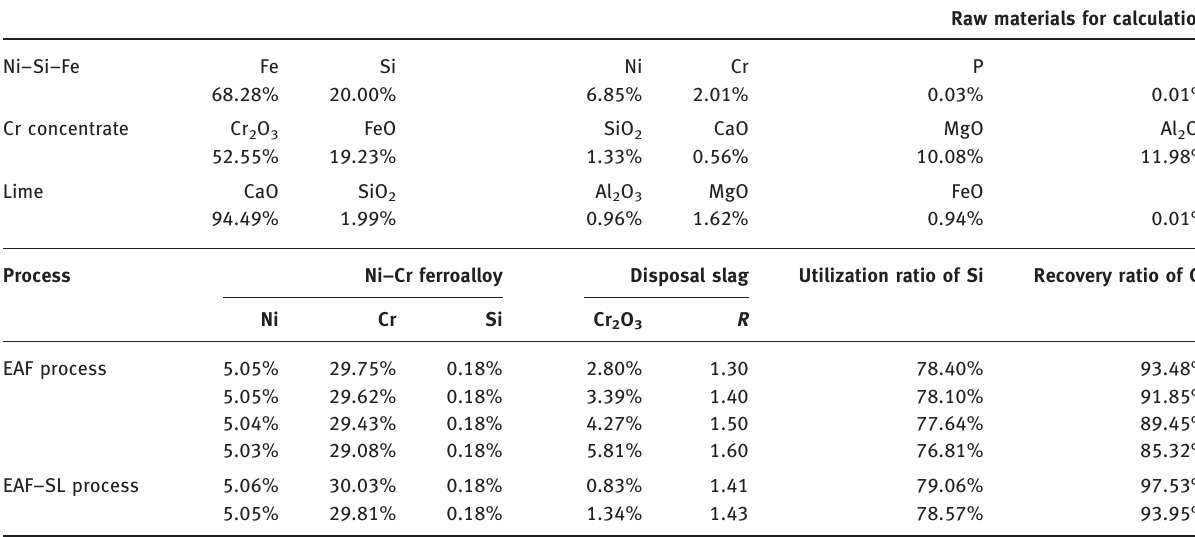
Raw materials for